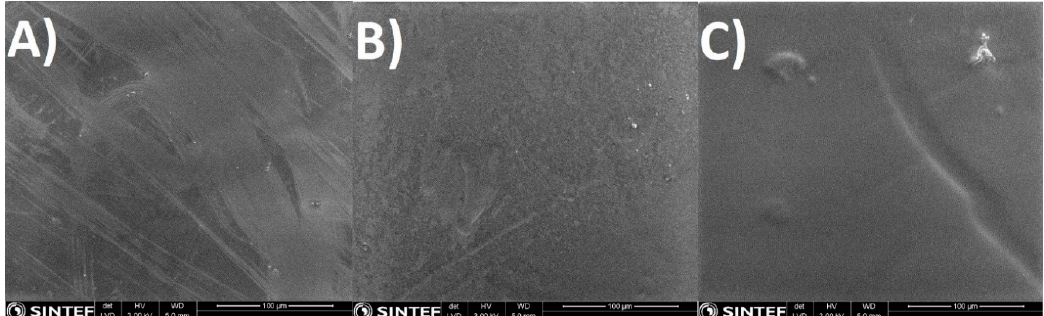
Figure 3. SEM-SE surface pictures from the PSf support flat sheet membranes ( A ) PVA; ( B ) Amidino POSS ® /PVA: 5%, Lactamide POSS ® /PVA: ( C ) 5%.